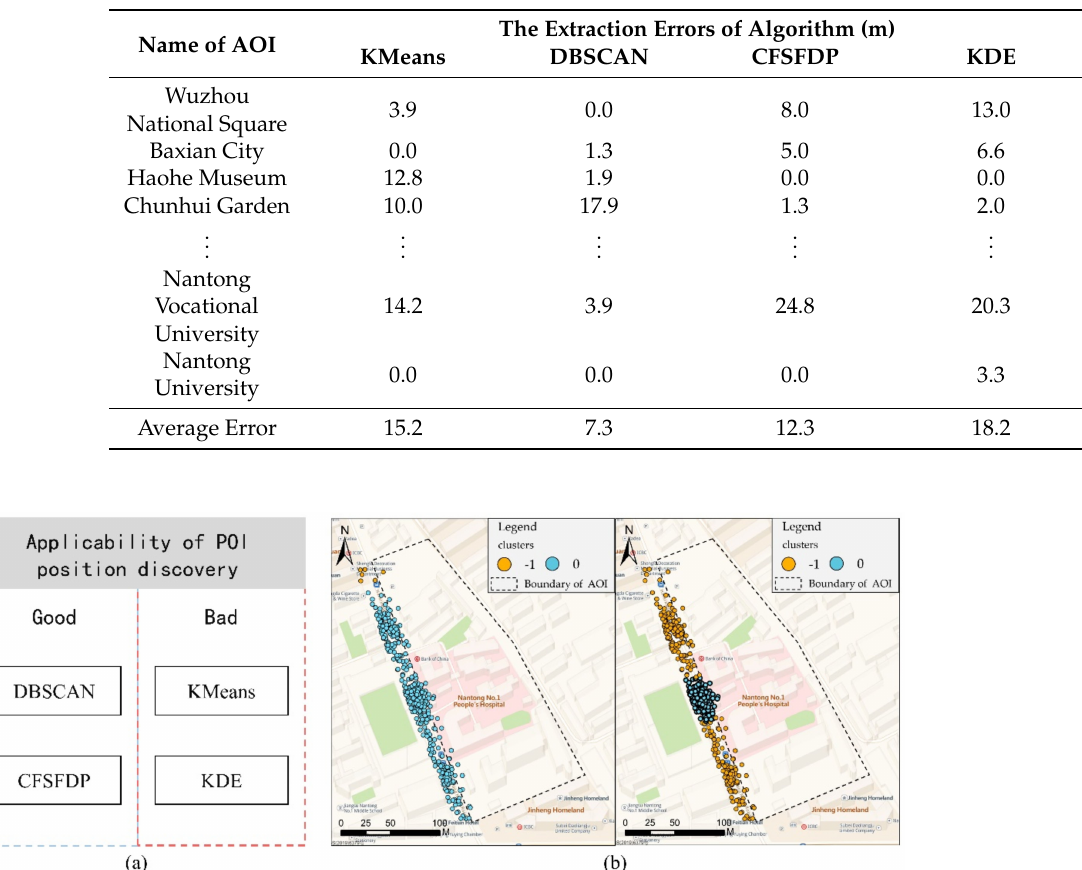
Table 7. Average errors in the discovery of the positions of POIs.